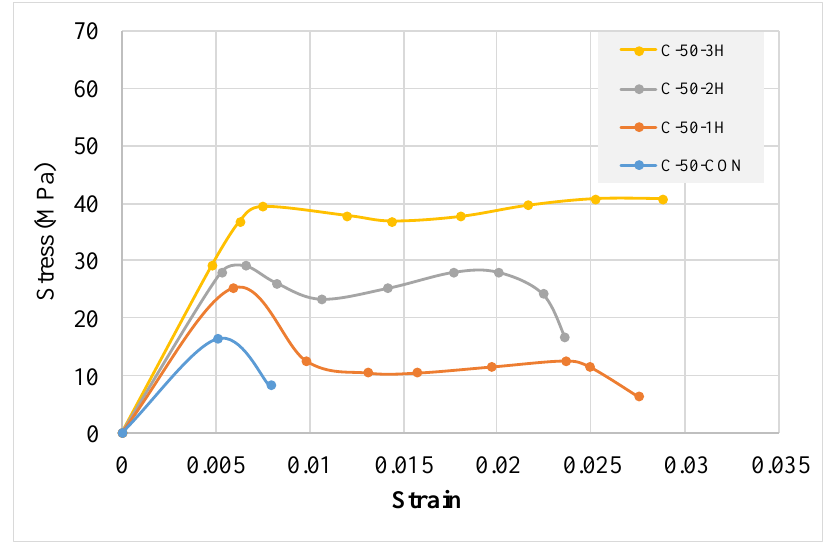
Figure 10. Compressive stress versus strain response of Group 2 cylinders.